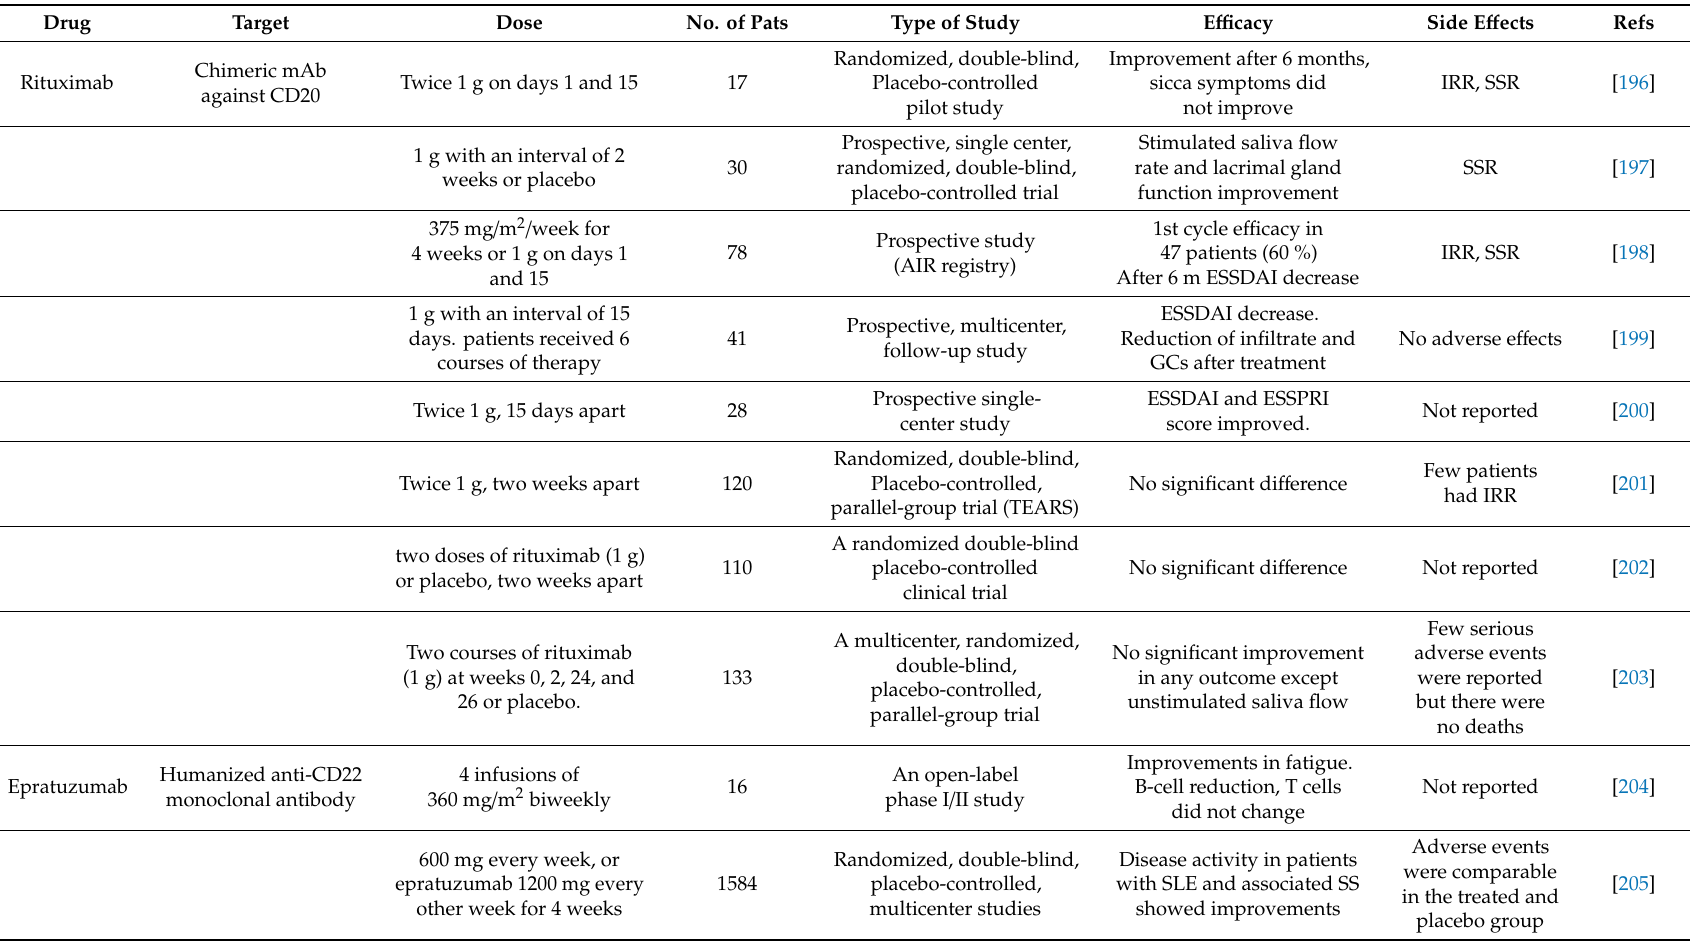
Table 1. B cell-targeted therapies in SS